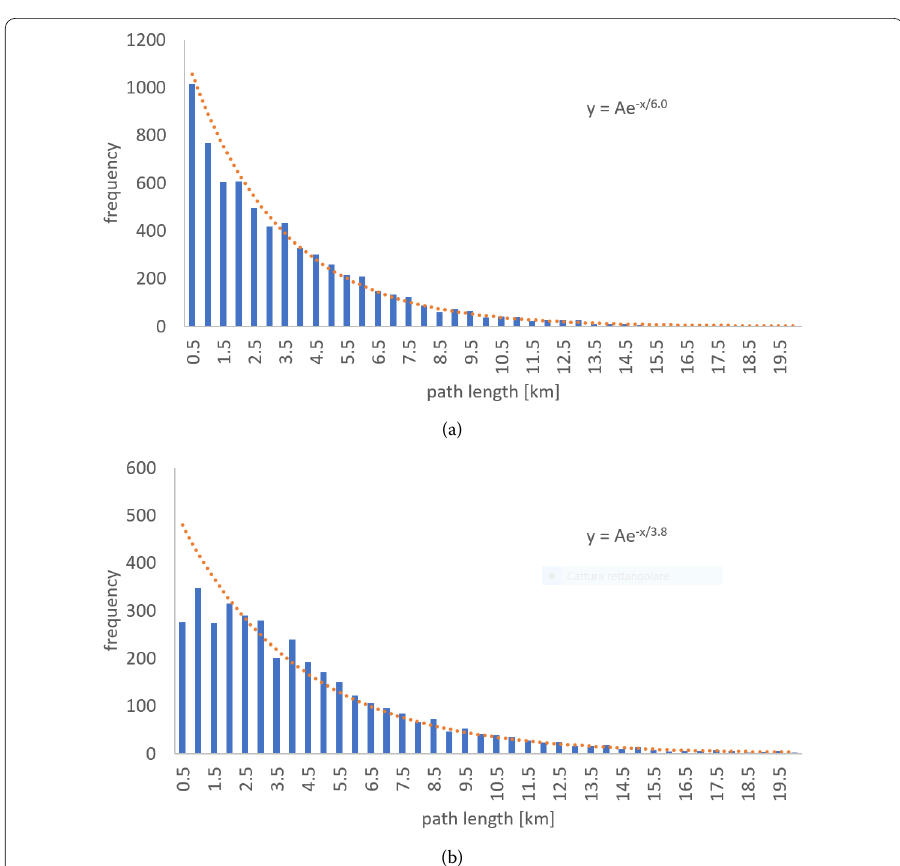
Figure 4 Distribution of the mobility path lengths reconstructed during the Carnival (top picture) and the FestadelRedentore (bottom picture) in the Venice historical centre. The dashed line is an exponential interpolation of the distribution tail whose equation is reported in the pictures